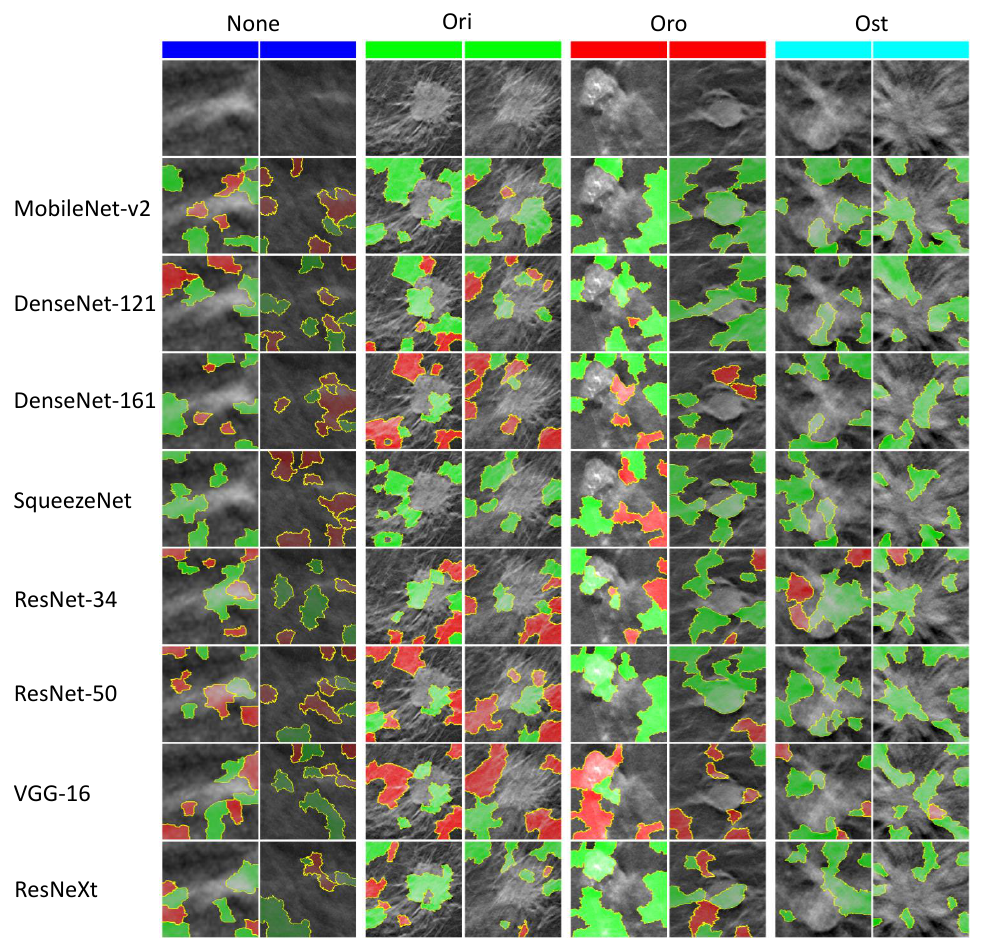
Figure 12. The visualization of LIME superpixels positive and negative regions with the eight different CNN architectures considered throughout this study. To illustrate the better view, two examples for each class are portrayed and the ground truth class label is provided above the set of each image. The red color highlights the negatively contributing superpixels, whereas the green represents otherwise. The header bar is used to distinguish among several classes and is colored uniquely. The similar color of header for two images represents the samples chosen from the same